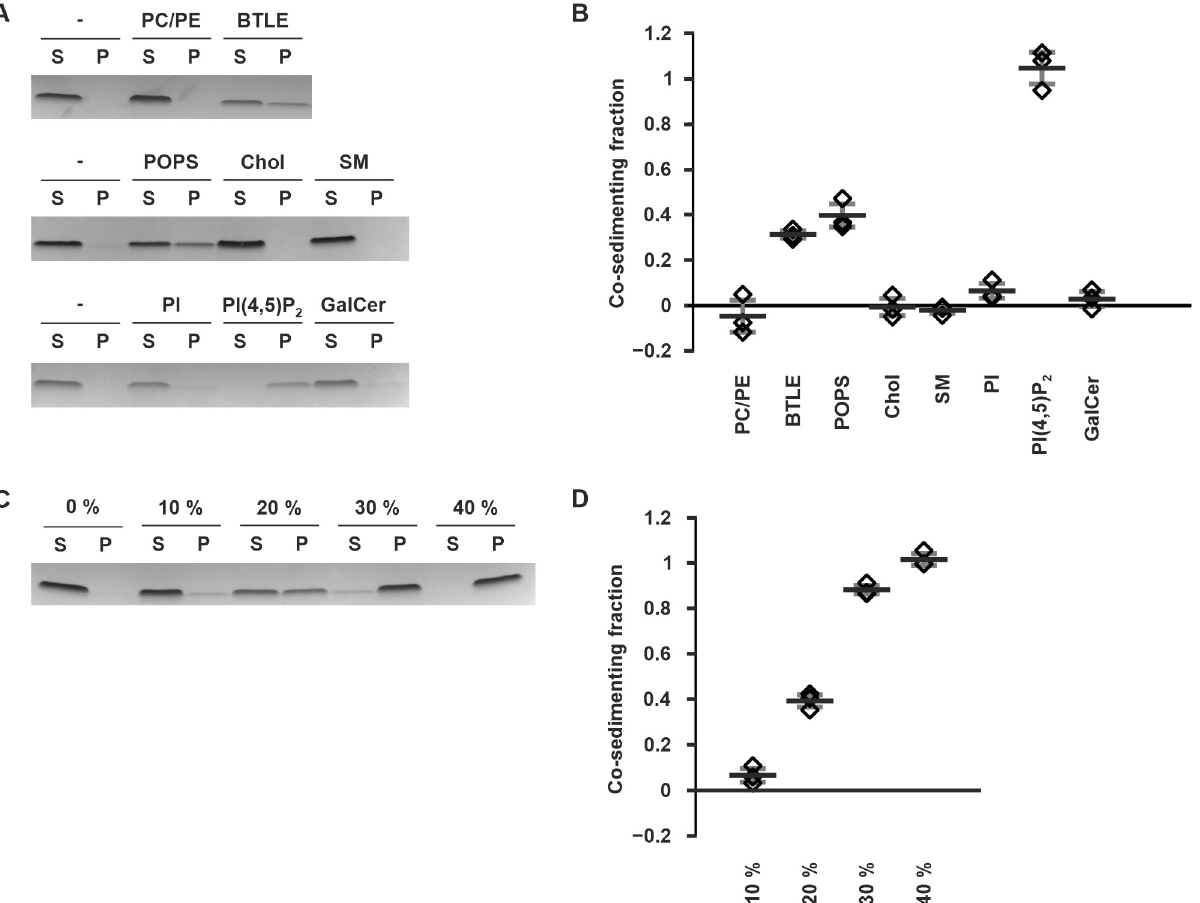
Fig 1. Full-length C protein binds preferentially to negatively-charged lipids. A, B Full-length C protein co-sedimentation with liposomes of different compositions. ( A ) shows representative SDS-PAGE bands with S indicating the supernatant and P the pellet. ( B ) shows densitometric quantitation of the co-sedimenting fraction from the pellet. PC/PE refers to pure DOPC/DOPE liposomes, BTLE to pure BTLE liposomes, a dash to the no liposome control and the other labels to DOPC/DOPE liposomes supplemented POPS, Chol, SM, PI, PI(4,5)P 2 or GalCer. C, D Full-length C protein co-sedimentation with liposomes containing varying amounts of POPS. ( C ) shows representative SDS-PAGE bands where S indicates the supernatant and P the pellet with the POPS percentage indicated above the lanes. ( D ) shows densitometric quantitation of the co-sedimenting fraction from the pellet with the w/w percentage of POPS in the liposomes is indicated on the Y axis. Data information: In ( B ) and ( D ), data are shown as the averages of three replicates with the error bars representing the standard deviation (s.d.). Individual measurements are shown as diamonds. Data are normalized against no liposome ( B ) or 0% POPS control ( D